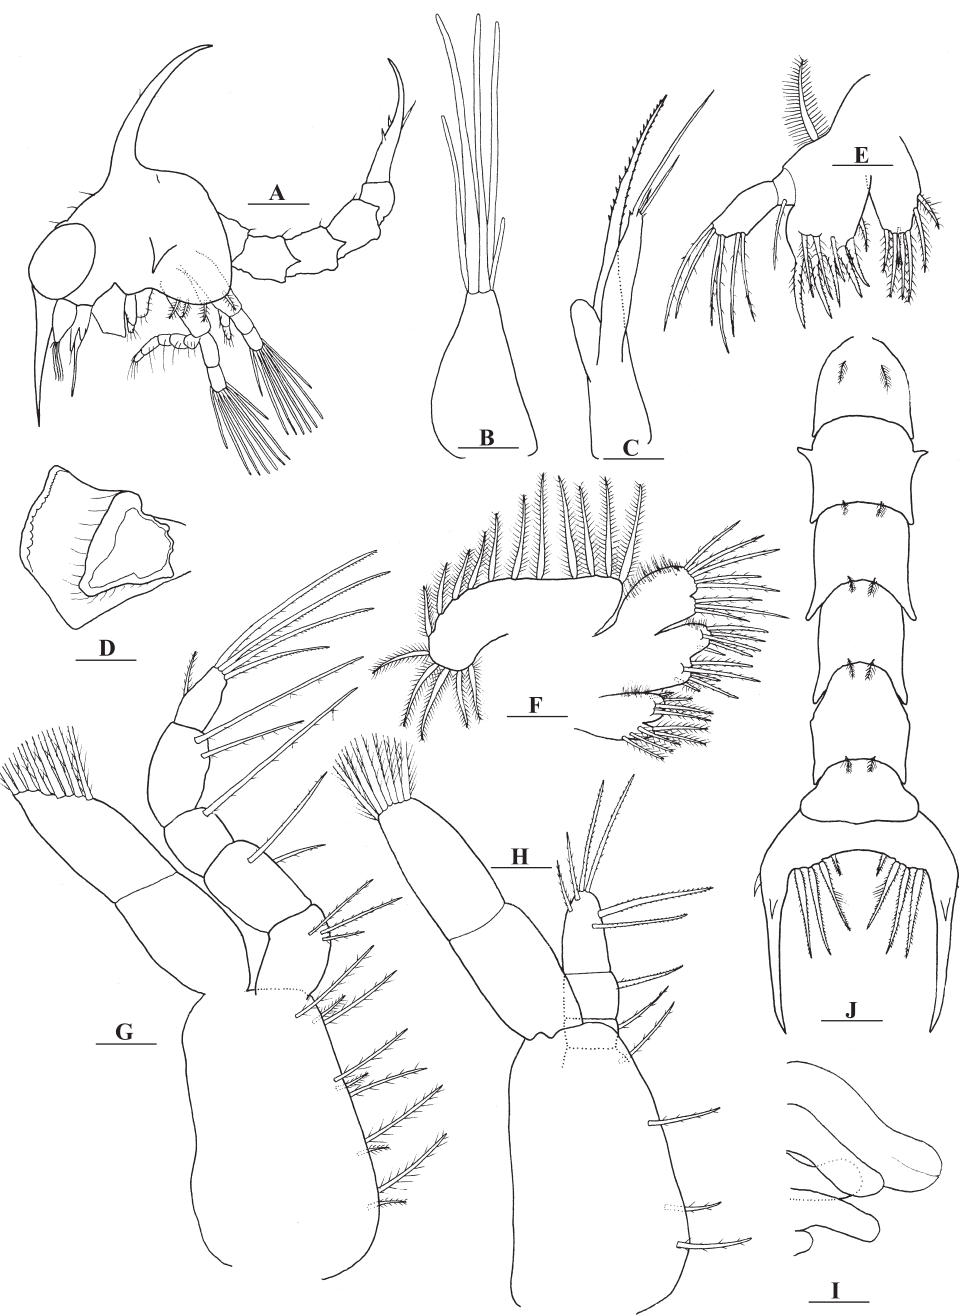
Fig. 3. – Pilumnoides hassleri . Zoea iii. A, whole animal, lateral view; B, antennule; C, antenna; d, mandible; e, maxillule; F, maxilla; G, first maxilliped; h, second maxilliped; i, pereiopods buds; J, abdomen. scale bars. A, 0.2 mm; B-i, 0.05 mm; J, 0.1